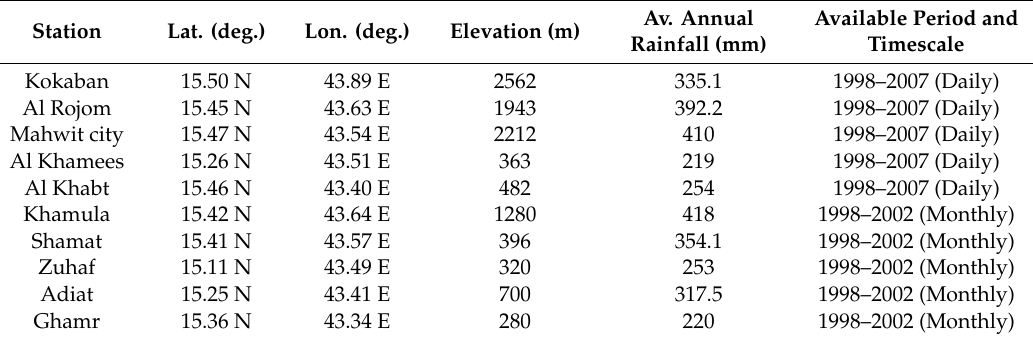
Table 1. A list of meteorological stations used for comparison with precipitation products.